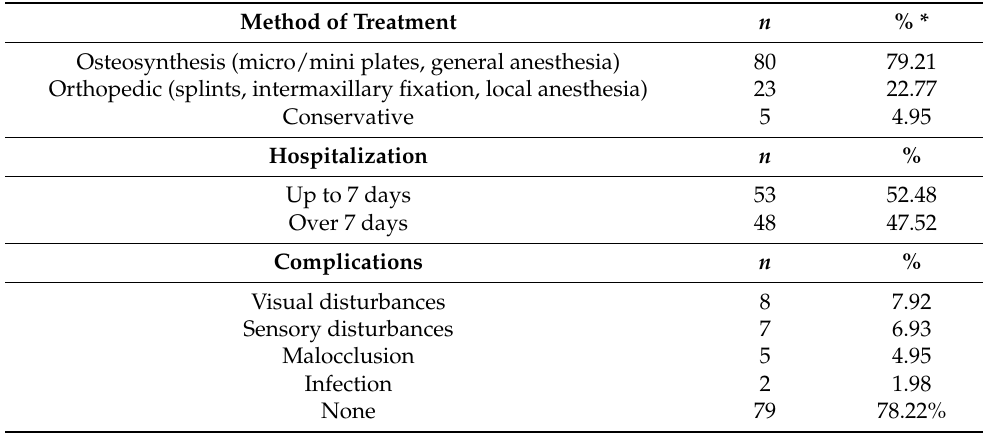
Table 6. Method of treatment, length of hospitalization, and long-term complications. Method of Treatment n % * Osteosynthesis (micro/mini plates, general